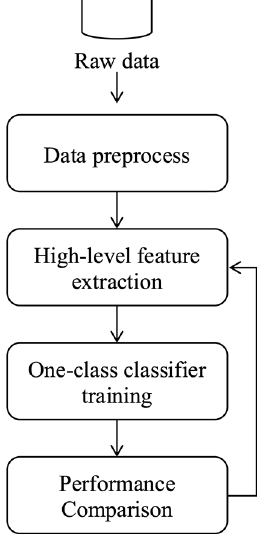
Figure 1. Research structure and